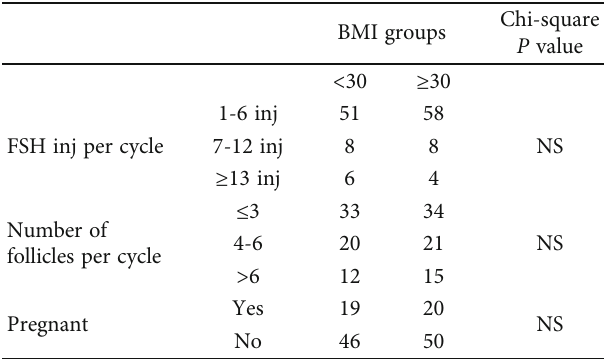
Table 2: Number of follicles and FSH injections used in each group.